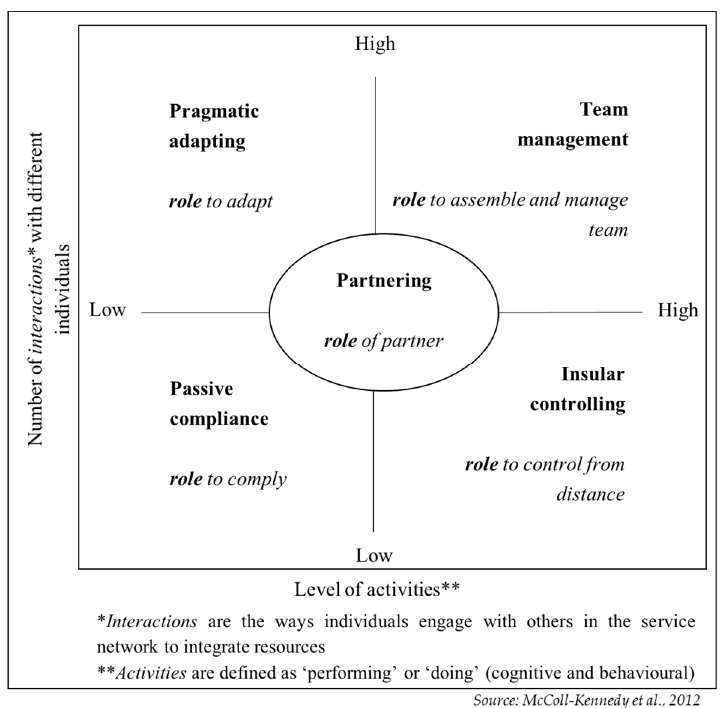
Figure 1. Customer value cocreation practice styles (CVCPS) framework.